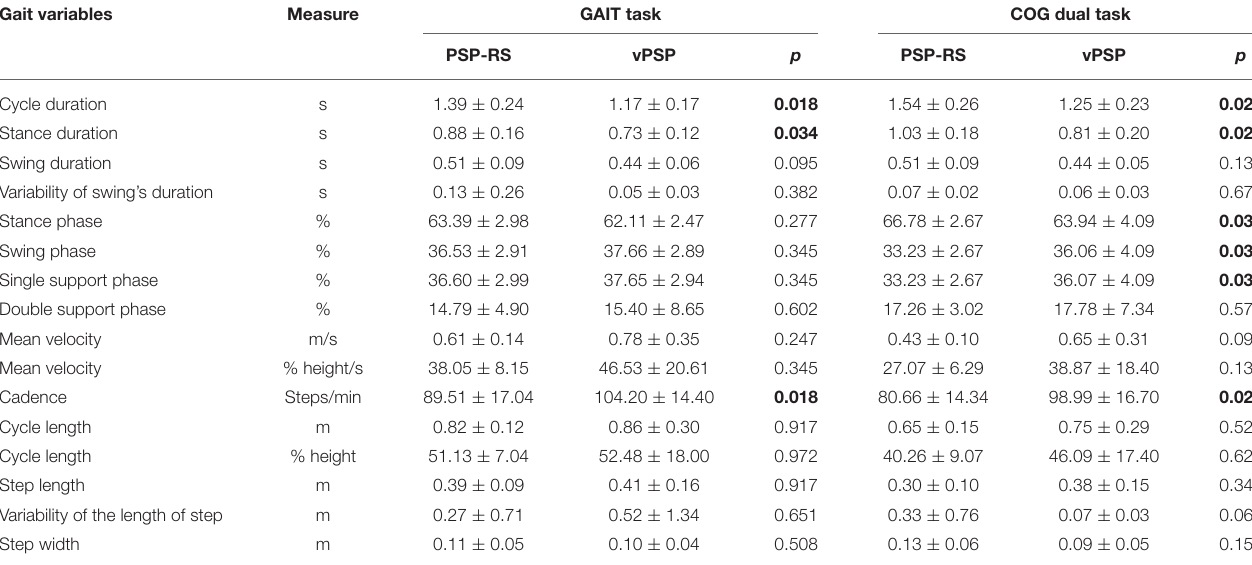
TABLE 2 | Univariate statistical analysis comparing all gait parameters between PSP-RS and vPSP.